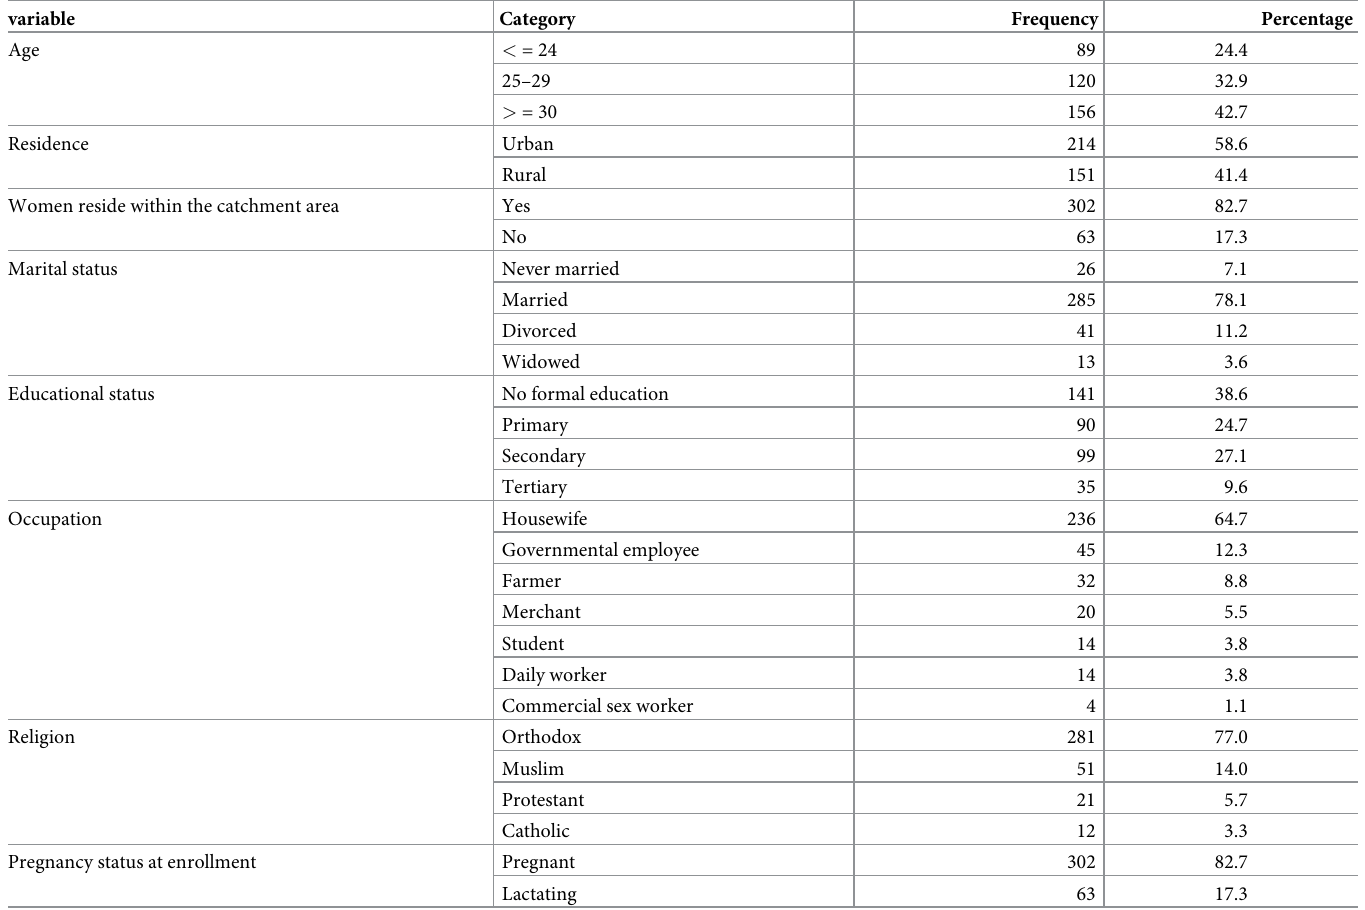
Table 1. Socio-demographic and maternal characteristics of women at enrolment to option B+ PMTCT program in Pawi district health facilities, northwest Ethio- pia, June 2013- March 2021.